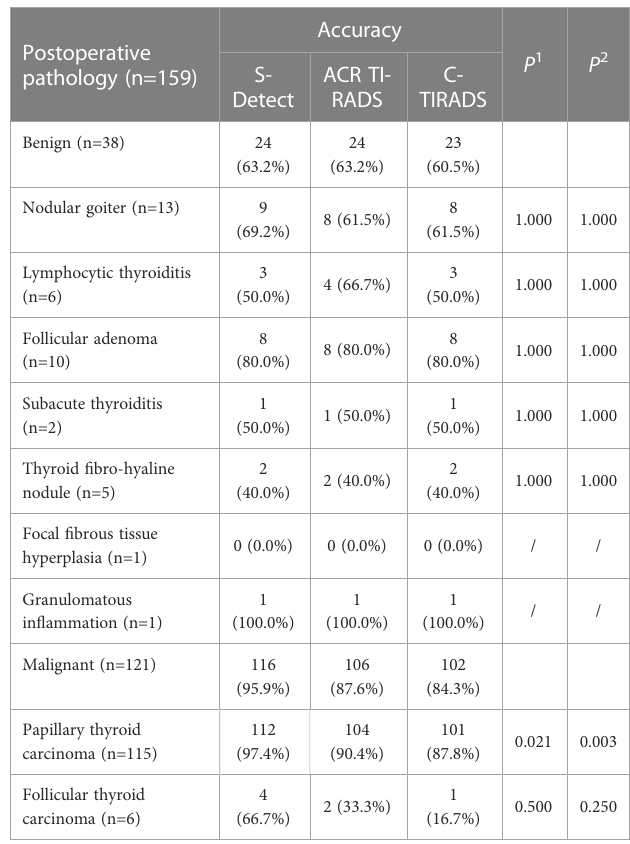
TABLE 8 Final Pathology of the cytologically indeterminate thyroid